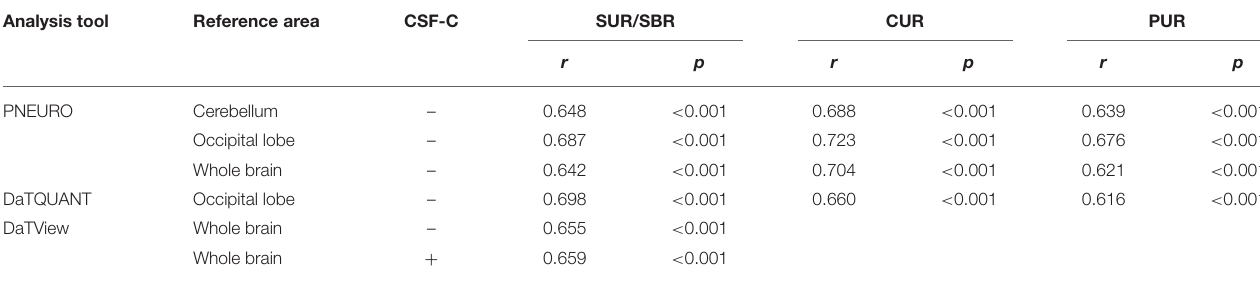
TABLE 3 | Correlation between the SUR/SBR, CUR and PUR of DAT-SPECT and those of DAT-PET. Analysis tool